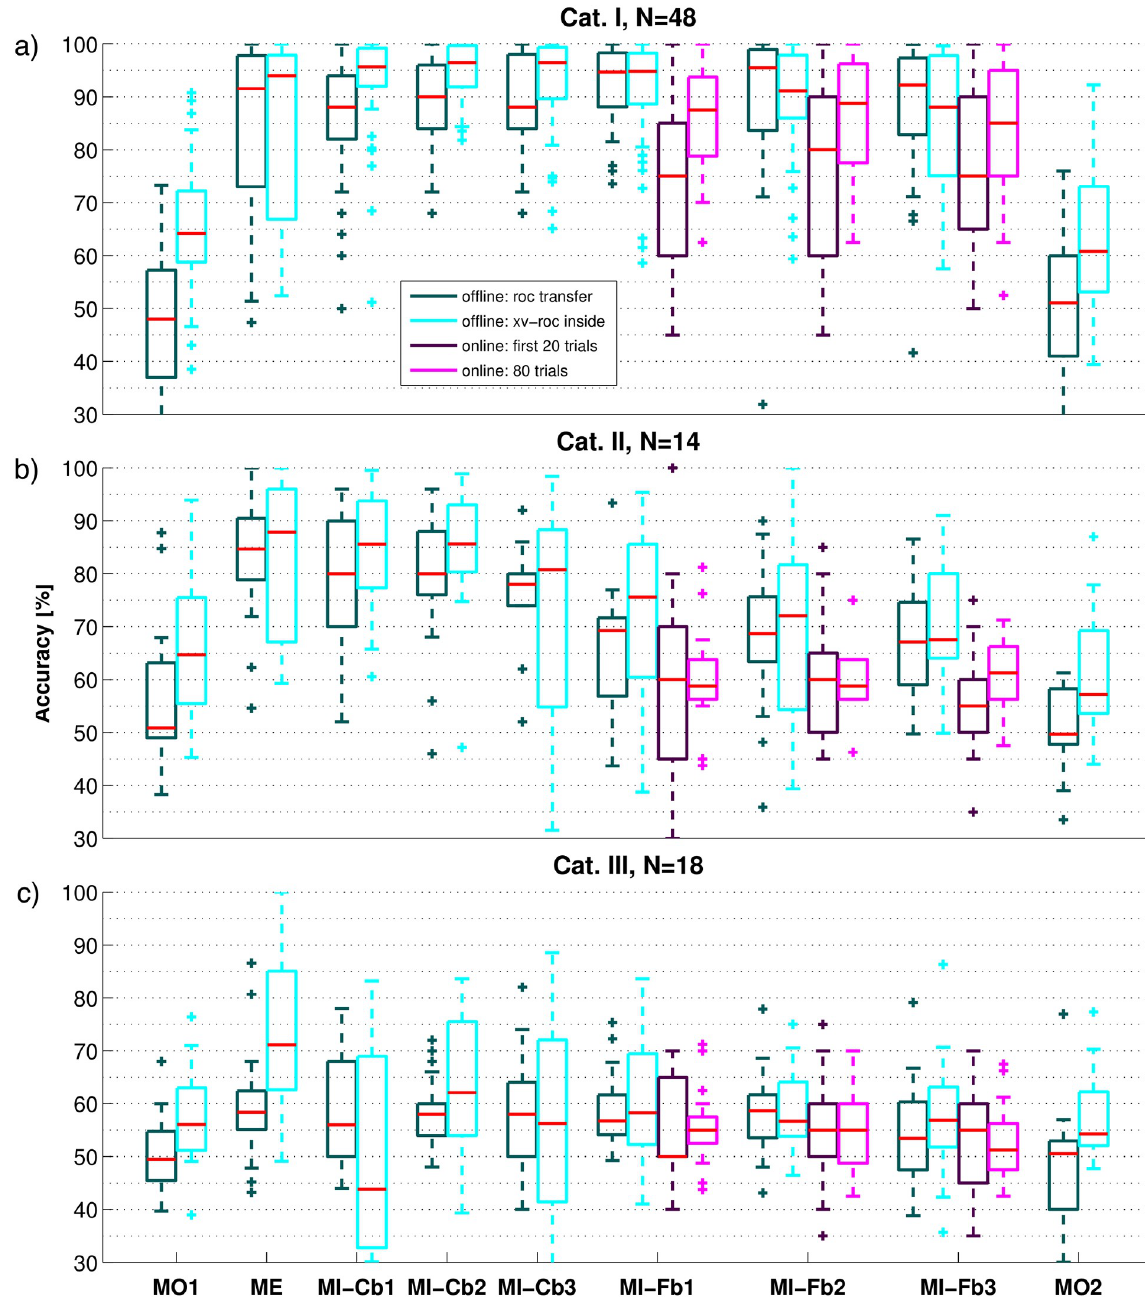
Fig 10. Box plots of the offline accuracy obtained for each run. The run names are indicated on the x-axis of the last row. Panels a), b) and c) correspond to Cat. I, II and III respectively. The dark cyan boxes refer to the transfer accuracy, obtained using subject-specific parameters, CSP filters and LDA calculated on the three MI-Cb runs during the experiment. For the offline accuracy of MI-Cb runs, CSP filters and LDA were again calculated on two MI-Cb runs and tested on the run itself. The cyan boxes refer to the inside accuracy, obtained selecting subject-specific band and time interval on the run itself and training CSP and LDA by LOO-CV. For the three MI-Fb runs, the online performance is also depicted: purple boxes for the first 20 trials used for bias adaptation, magenta boxes for the 80 trials relevant for the calculation of the online performance). Red line in the middle of the box indicates the median accuracy, the lower and the upper limit of the box indicate respectively the 25 and 75 percentiles of the accuracies, and the whisker length is calculated as the difference between the 75 and 25 percentiles. Accuracies outside the whiskers are considered outliers and are indicated by a